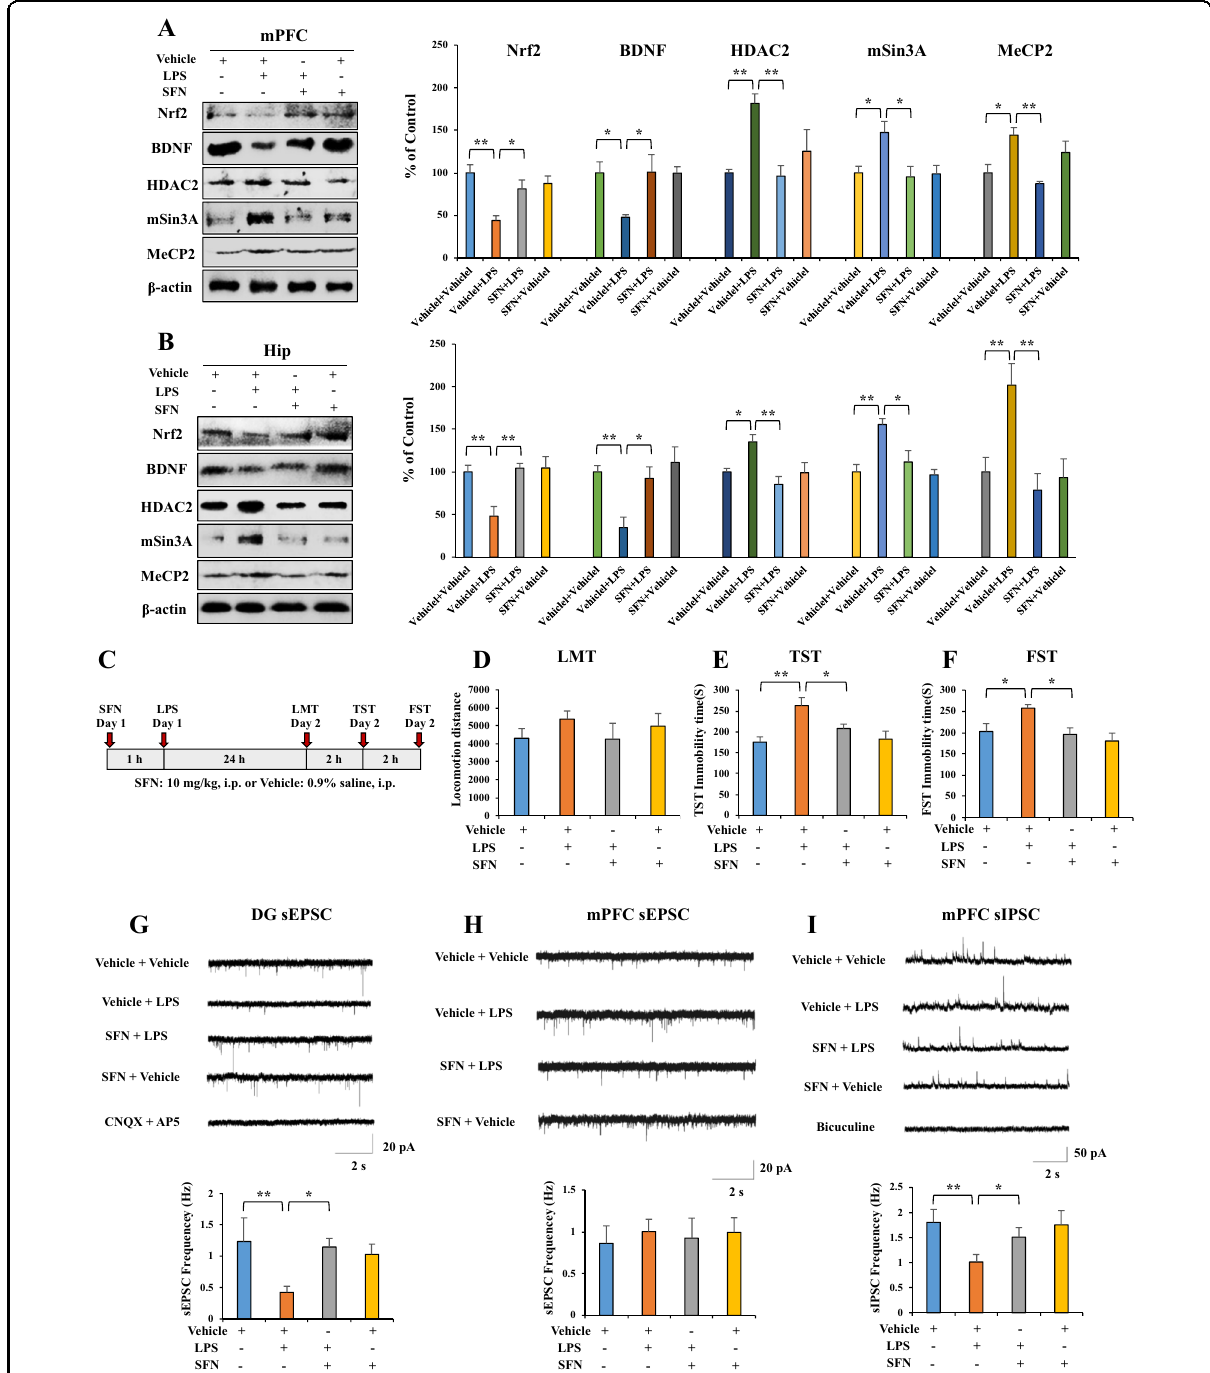
Fig. 3 SFN shows bene fi cial effects for depression-like behavior by altering Nrf2, BDNF, HDAC2, mSin3a, MeCP2 expression, and attenuating the decrease of frequency of sEPSC and sIPSC in hippocampus and mPFC neurons. A , B Western blot analysis for Nrf2, BDNF, and MeCP2 in mPFC and hippocampus (mean ± SEM, n = 4 per group, one-way ANOVA, * p < 0.05 and ** p < 0.01). C The schedule of behavior test and treatment. D LMT: locomotion test, E TST: tail-suspension test, F FST: forced swimming test (mean± SEM, n = 7 or 8 per group, one-way ANOVA, * p < 0.05, ** p < 0.01). G Up: representative traces of sEPSC in hippocampal DG neurons. Scale bars represent 2 s, 20 pA. Down: histograms of sEPSC frequency in hippocampal DG neurons (mean ± SEM, n = 7 – 9 neurons of three mice per group, one-way ANOVA, * p < 0.05, ** p < 0.01). H Up: representative traces of sEPSC in mPFC neurons. Scale bars represent 2 s, 20 pA. Down: histograms of sEPSC frequency in mPFC neurons (mean ± SEM, n = 8 – 10 neurons of three mice per group). I Up: representative traces of sIPSC in mPFC neurons. Scale bars represent 2 s, 50 pA. Down: histograms of sIPSC frequency in mPFC neurons (mean ± SEM, n = 8 – 10 neurons of three mice per group, one-way ANOVA, * p < 0.05, ** p <